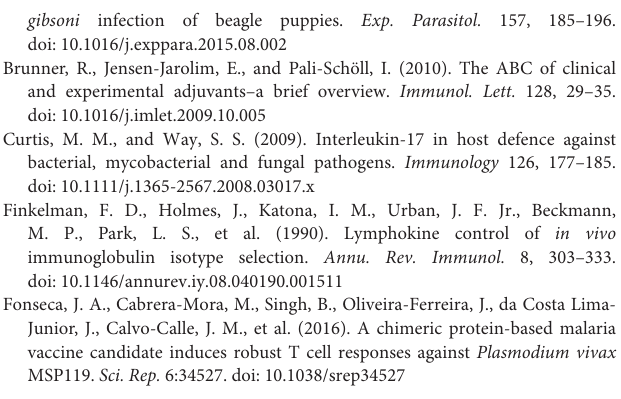
Supplementary Figure S1 | Levels of chemokines in culture supernatants of splenocytes. BALB/c mice, in the vaccination or sham vaccination groups, followed by a challenge with 1 × 10 7 erythrocytes infected with B. microti , were sampled on days 0, 7, 14, and 21. Splenocytes were cultured in vitro and stimulated with PBS, BMSA, or ConA (data not shown). (A–F) The levels of G-CSF, GM-CSF, MCP-1, MIP-1 α , MIP-1 β , and MIP-2 in culture supernatants were determined using a Mouse Cytokine/Chemokine Magnetic Bead Panel. The data represent two individual experiments. ( ∗ p < 0.05; ∗∗ p < 0.01; ∗∗∗ p < 0.001). Supplementary Figure S2 | Levels of cytokines in sera of mice immunized with BMSA or Tris-HCl. BALB/c mice, in the vaccination or sham vaccination groups, followed by a challenge with 1 × 10 7 erythrocytes infected with B. microti , were sampled on days 0, 7, 14, and 21. (A–F) The levels of G-CSF, GM-CSF, MCP-1, MIP-1 α , MIP-1 β , and MIP-2 in sera were determined using a Mouse Cytokine/Chemokine Magnetic Bead Panel. The data represent two individual experiments. ( ∗ p < 0.05; ∗∗ p < 0.01; ∗∗∗ p < 0.001). Supplementary Figure S3 | The network of cytokines and immunoglobulins analyzed using IPA. The network connects the most up-regulated cytokines and immunoglobulin G subclasses in serum. Dotted lines indicate indirect